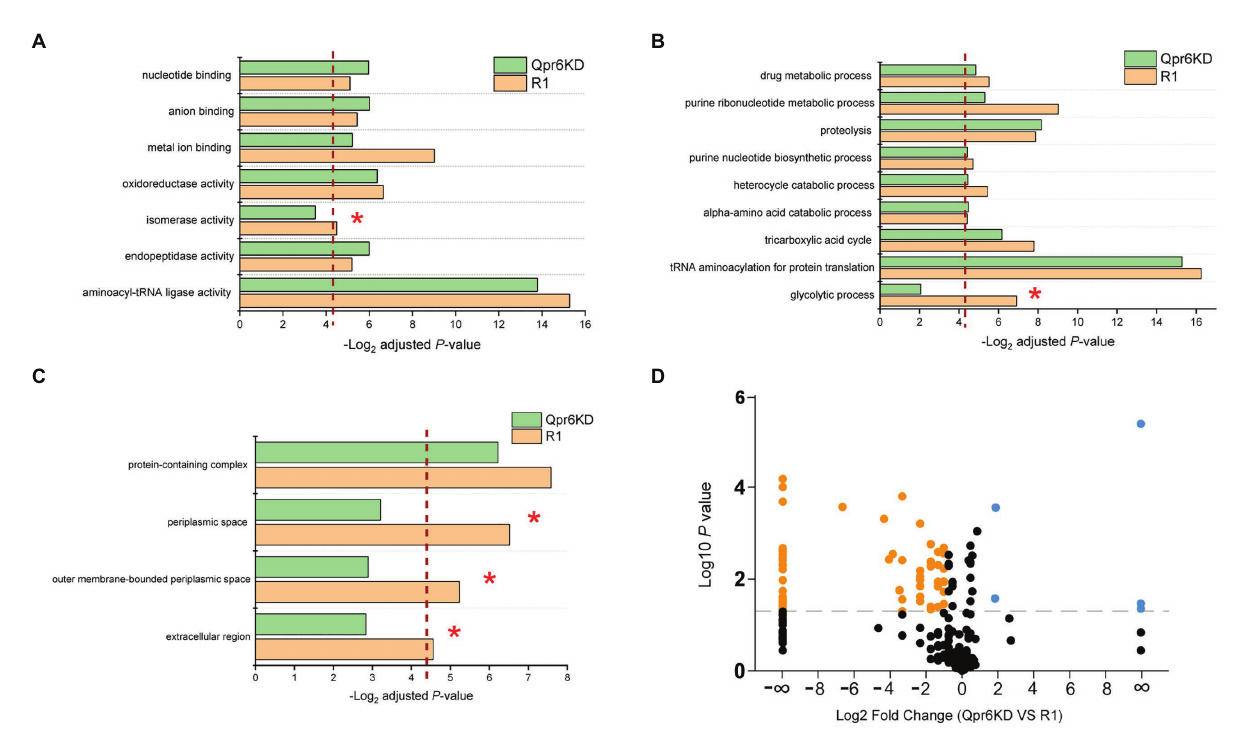
FIGURE 4 | Effects of Qpr6 on the periplasmic protein transport in D. radiodurans . (A–C) Gene Ontology enrichment analysis of periplasmic-associated proteins in R1 and Qpr6 KD based on molecular function (A) , biological processes (B) , and subcellular location (C) . The pathways that are not significantly enriched in Qpr6 KD are indicated with asterisks. The red dashed line shows the threshold of significance ( p ≤ 0.05). (D) Volcano plot showing the differential expressed proteins in the periplasmic space of Qpr6 KD compared to R1. Black spots represent the proteins showing no significantly differential expressions. Orange spots represent the proteins showing significant lower abundance in Qpr6 KD compared to R1. Light blue spots represent the proteins showing significant greater abundance in Qpr6 KD compared to R1. The gray line shows the threshold of significance ( p ≤